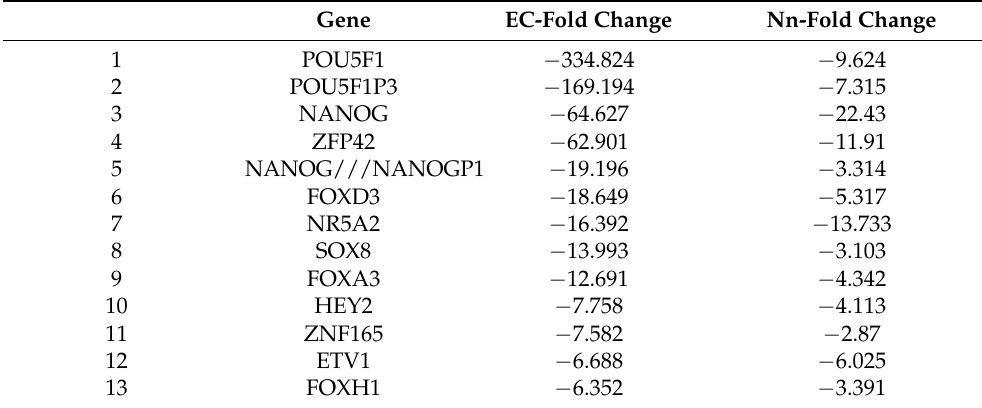
Table 2. Genes in transcription factor category that are downregulated in both endothelial and neural